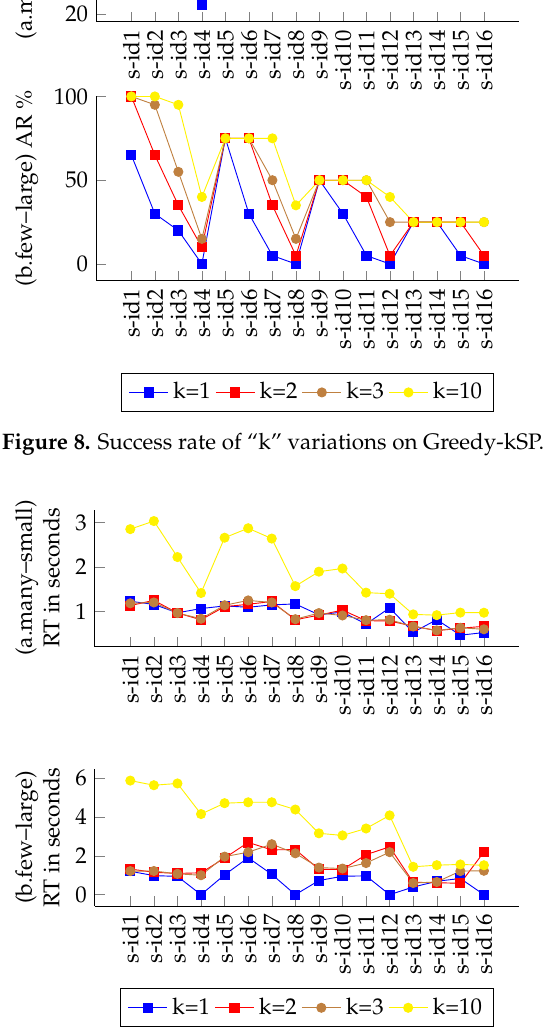
Figure 9. RT of the “k” variations on